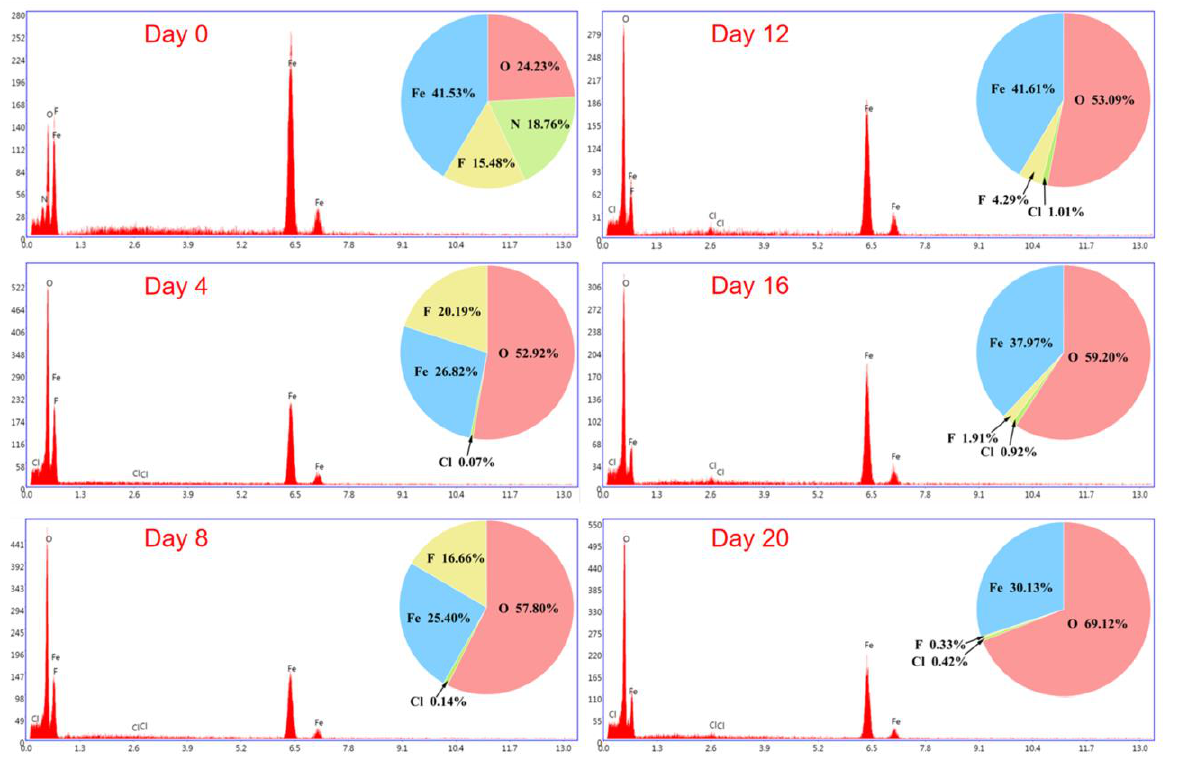
Figure 10. EDS spectra of the corrosion products of Q235 low-carbon steel after exposure to acceler- ated corrosive environments at different times.